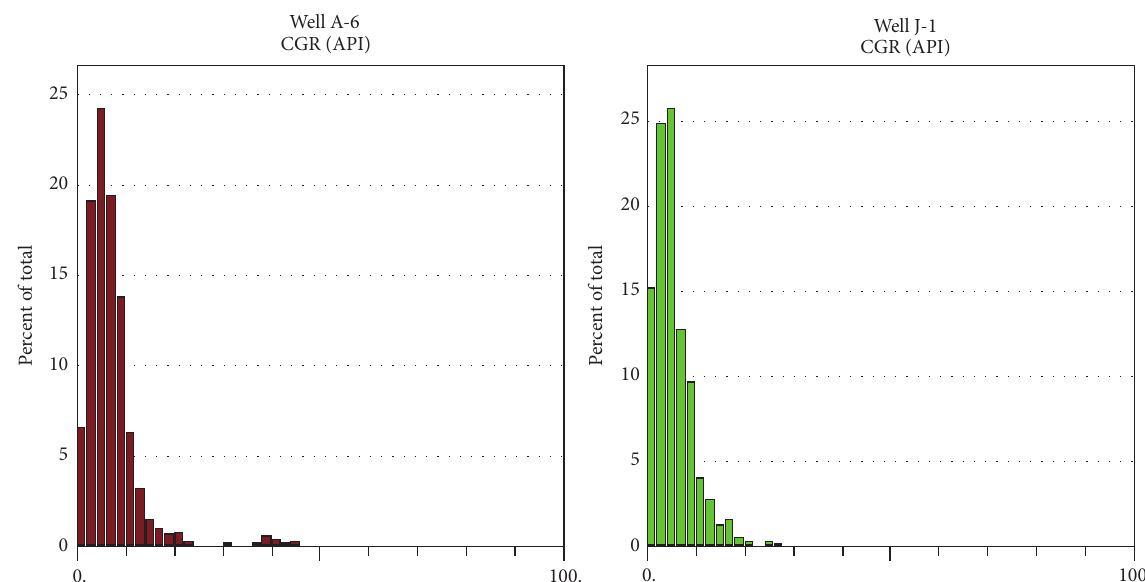
Figure 3: The CGR histogram (as the clay indicator) of Lower Fahliyan reservoir in wells A-6 and J-1. The value of the CGR is almost less than 20 API ∘ suggesting a clay-free reservoir.